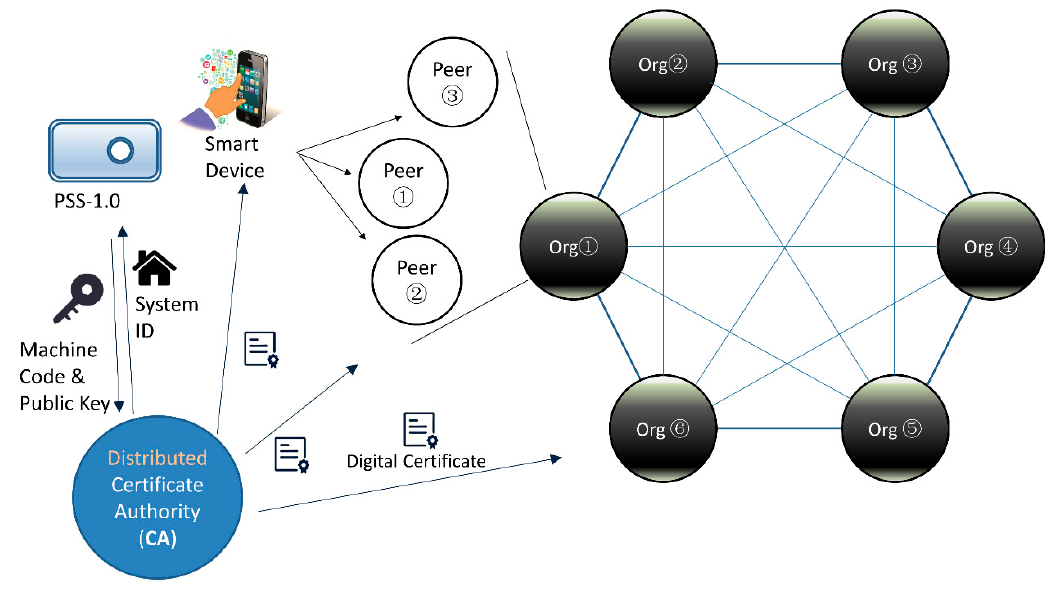
Figure 9. Blockchain system architecture.